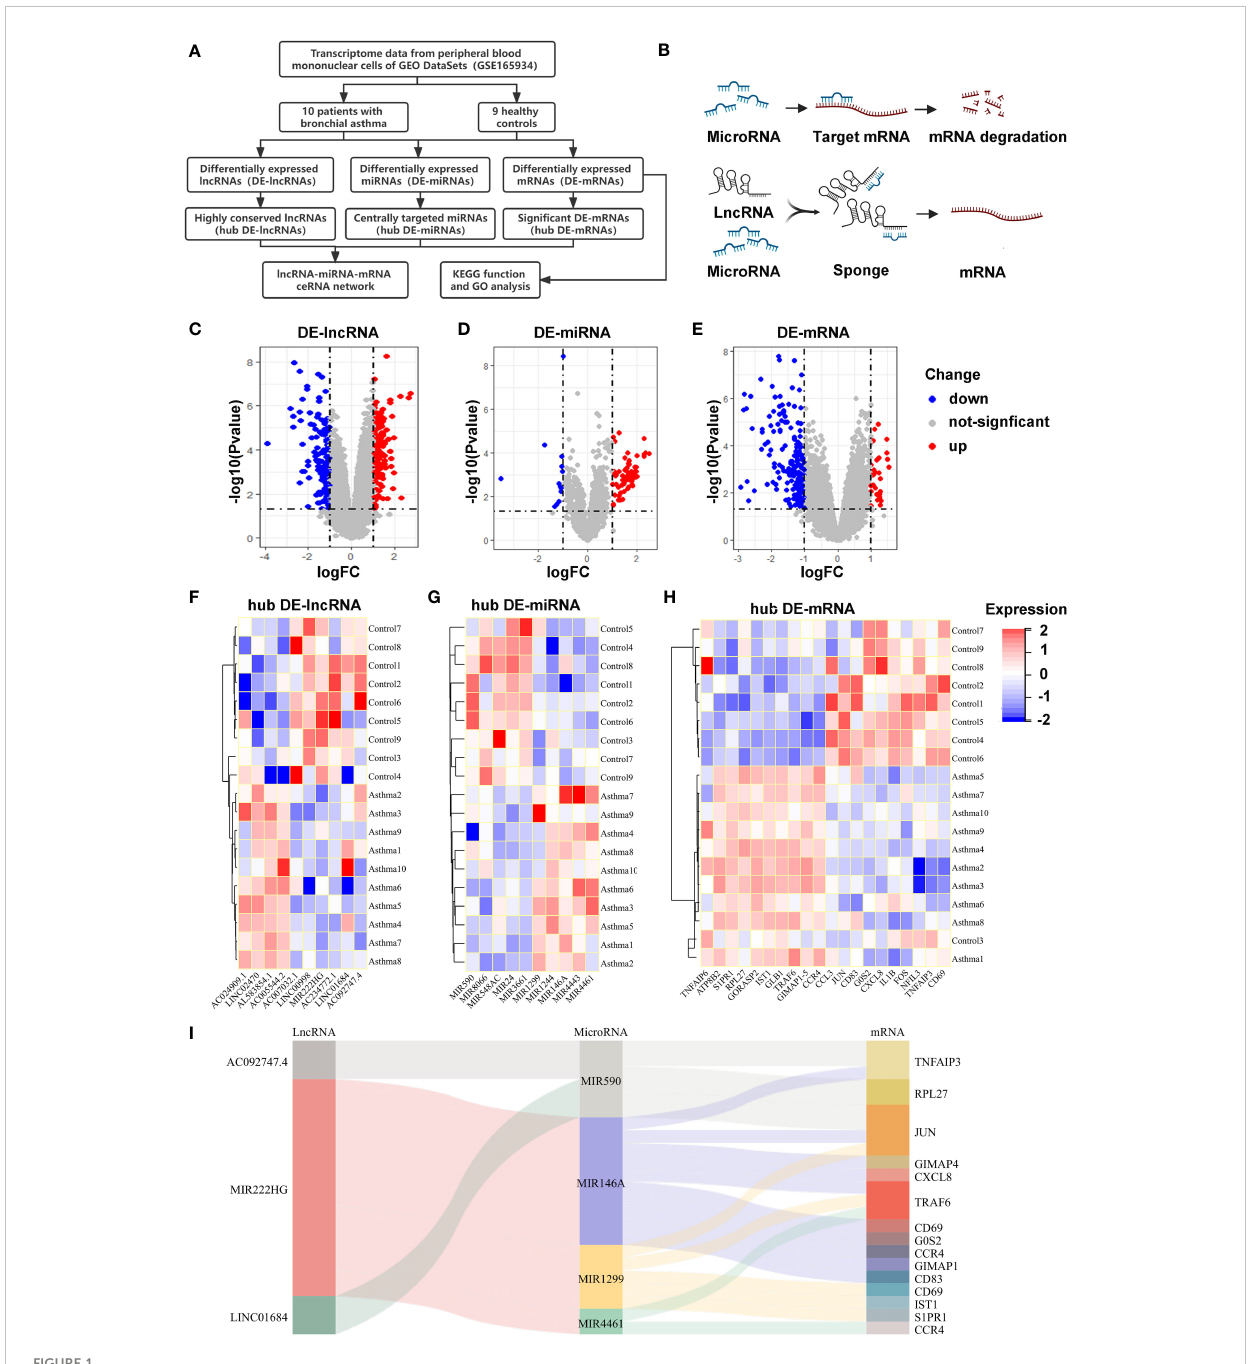
FIGURE 1 Differentially expressed RNAs in allergic diseases and construction of a ceRNA network (A) This fl ow chart showing the methodology of the bioinformatic analysis. (B) The interaction mechanism diagram of the ceRNA network. (C-E) Volcano plots of DE-lncRNAs (C) , DE-miRNAs (D) and DE-mRNAs (E) in PBMCs of allergic asthma, analyzed from the GEO database (GSE165934). (F-H) Heatmaps showing the selected hub DE-lncRNAs (F) , hub DE-miRNAs (G) , and hub DE-mRNAs (H) . (I) Sankey diagram showing the competing endogenous RNA network in allergic asthma. The screening criteria were |log 2 FC| ≥ 1 and P value <